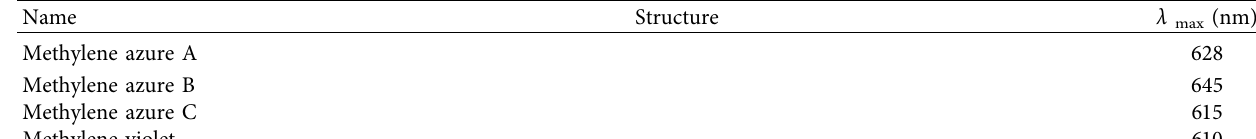
Table 3: Structures of methylene azure ( A , B , C ) and methylene violet